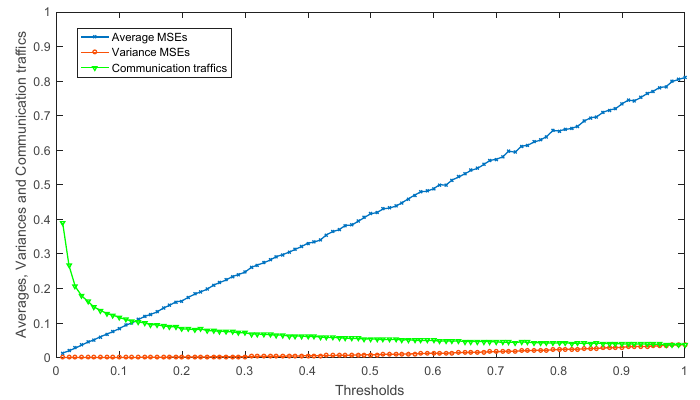
Figure 6. The statistical data of MSEs and communication traffics with different threshold .